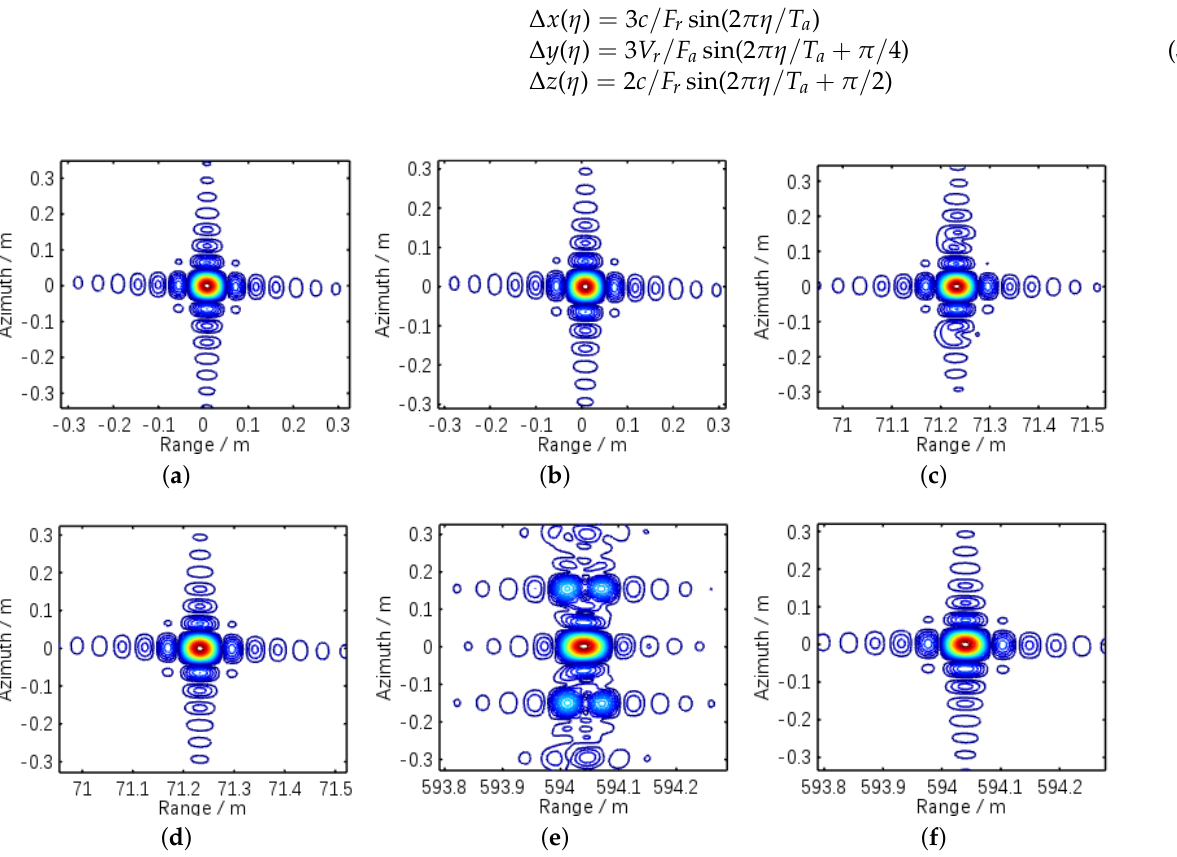
Figure 9. Comparison results of signal s 3 with the traditional OSM and RvOSM. ( a ) Point A with traditional OSM. ( b ) Point A with RvOSM. ( c ) Point B with traditional OSM. ( d ) Point B with RvOSM. ( e ) Point C with traditional OSM. ( f ) Point C with